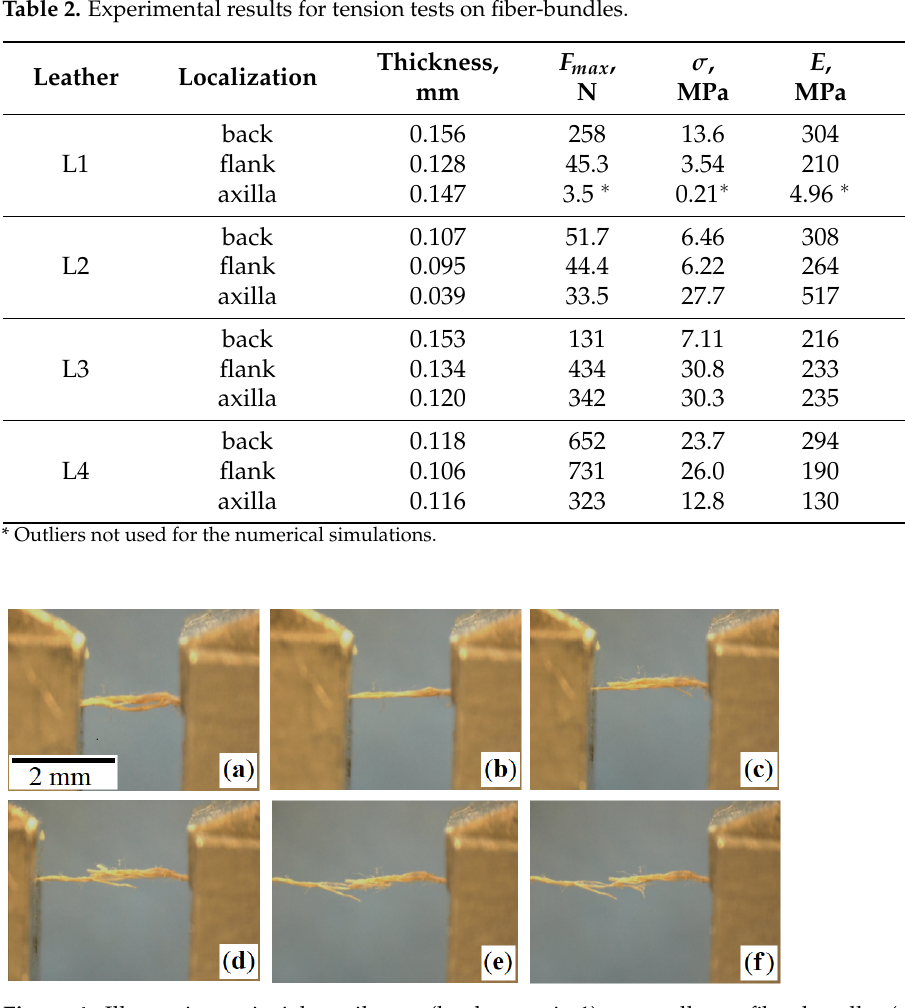
Figure 4. Illustrating uniaxial tensile test (load scenario 1) on a collagen fiber-bundle: ( a ) Initial state; ( b ) increased load causes fiber-bundle straightening and elongation; ( c ) slippage of fibers and beginning of fiber breakage; ( d , e ) progressing sequential fiber breakage; and ( f ) complete breakage of